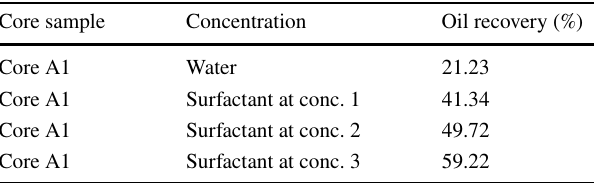
Table 5 Core flooding parameters and result for surfactant at different concentrations @0.2wt% to 0.5wt% for core A1